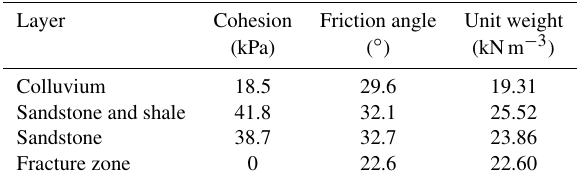
Table 2. Soil and rock